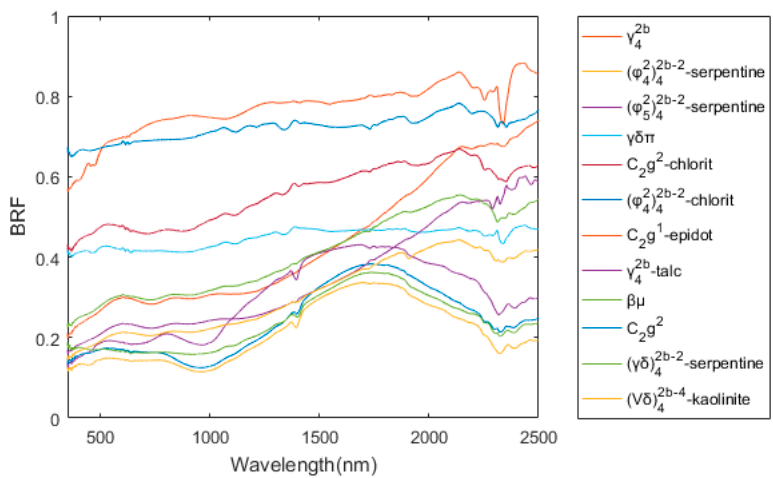
Figure 6. The BRF of samples collected with illumination zenith 45 ◦ and view zenith 0 ◦